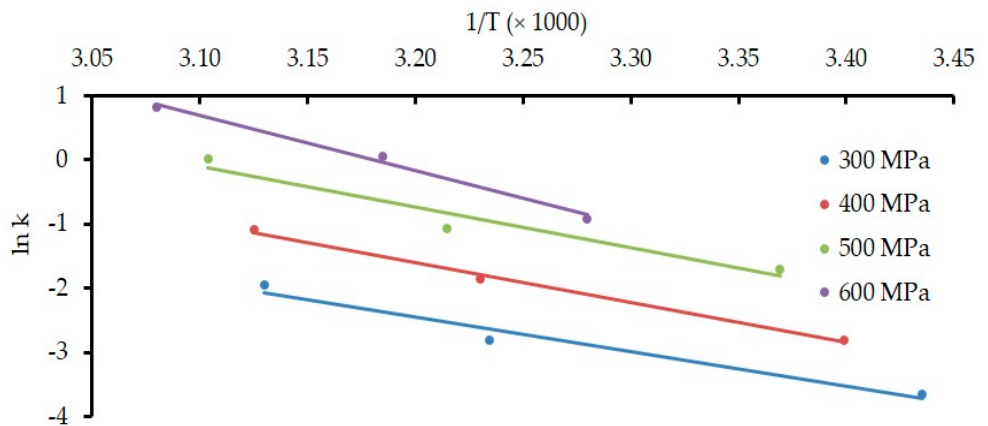
Figure 4. Effect of HPP on the rate of constant ( k ) for denaturation of α -Lac. Temperature at all HPP conditions ( T eff ) is presented in Table 1.